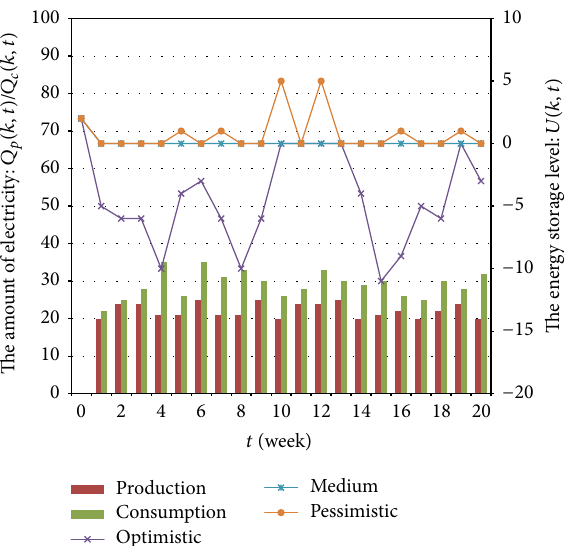
Figure 4: Trend of energy storage level at microgrid SC.